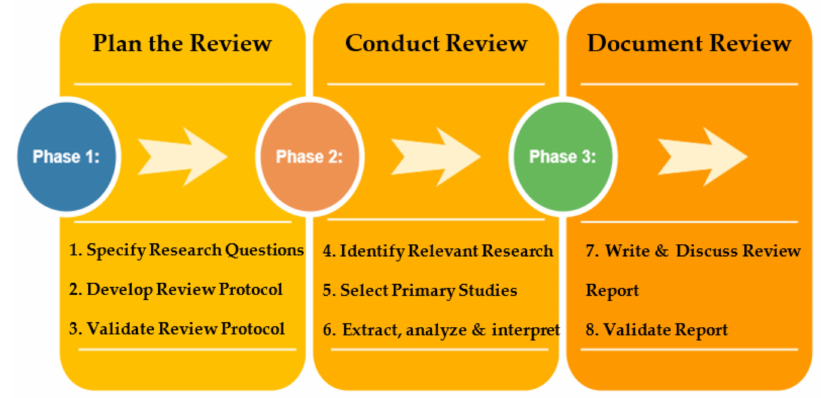
Figure 1. Systematic literature review